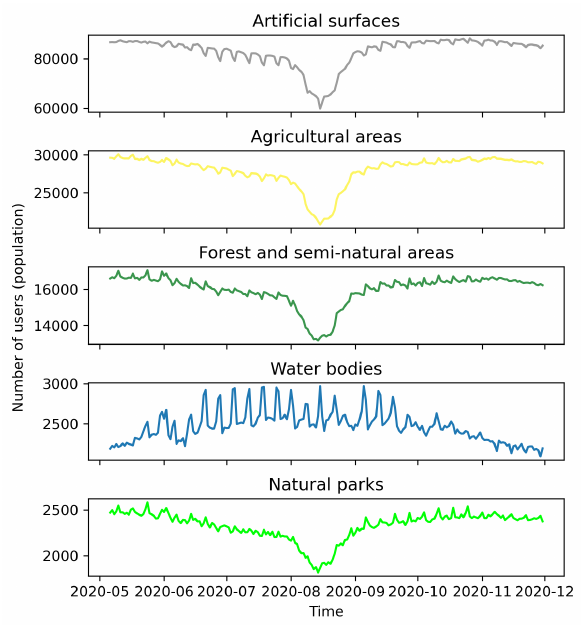
Figure 3. Time series of average users’ population observed in each CLC class and natural park areas of the Insubria